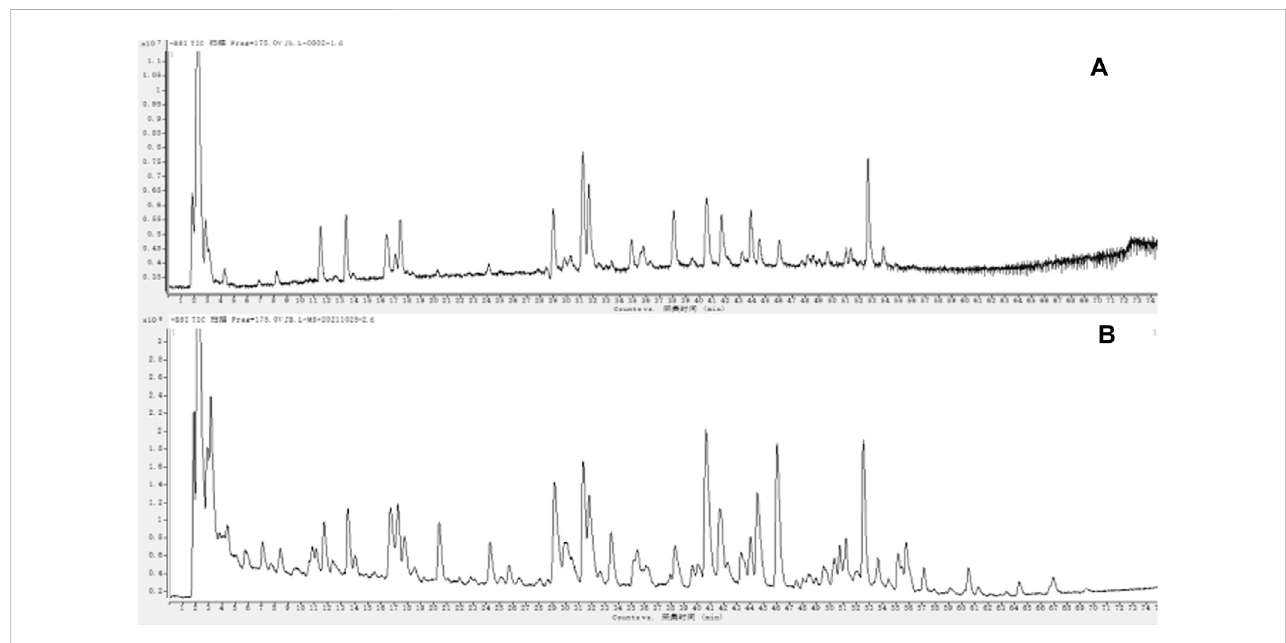
FIGURE 2 UPLC-Q-TOF-MS total ion chromatogram of Jinbei oral liquid in negative (A) and positive (B) ion mode See Supplementary Figure S2.